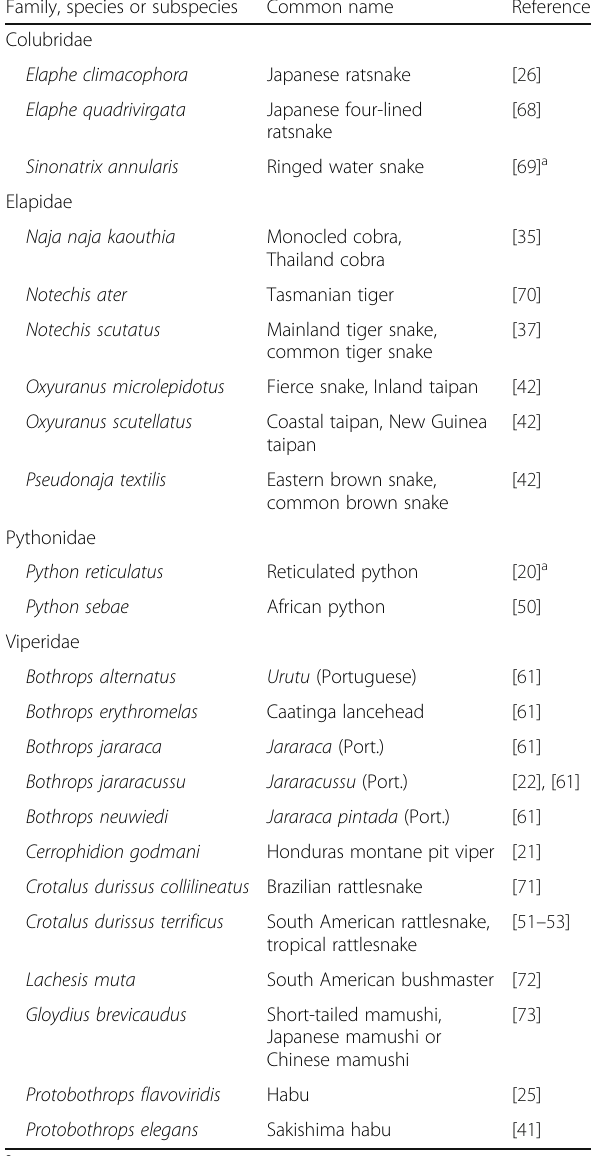
Table 3 Snake blood PLA 2 inhibitors in the structural